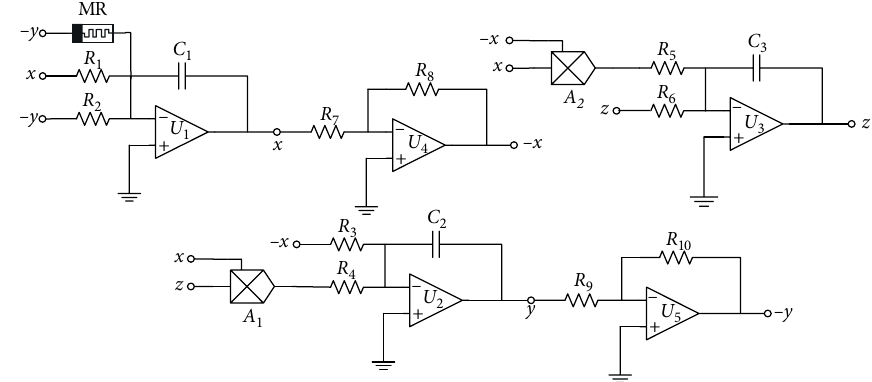
Figure 5: Hyperchaotic circuit by introducing memristor feedback.